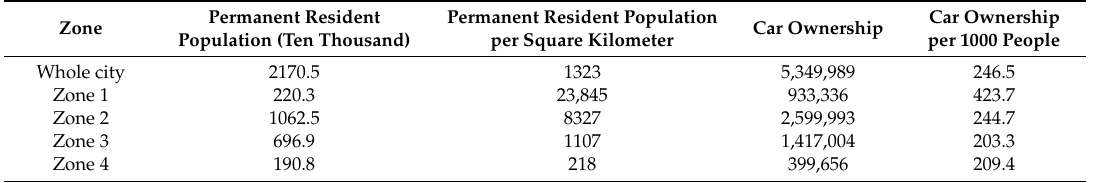
Table 4. Differences of other traffic characteristics in urban functional